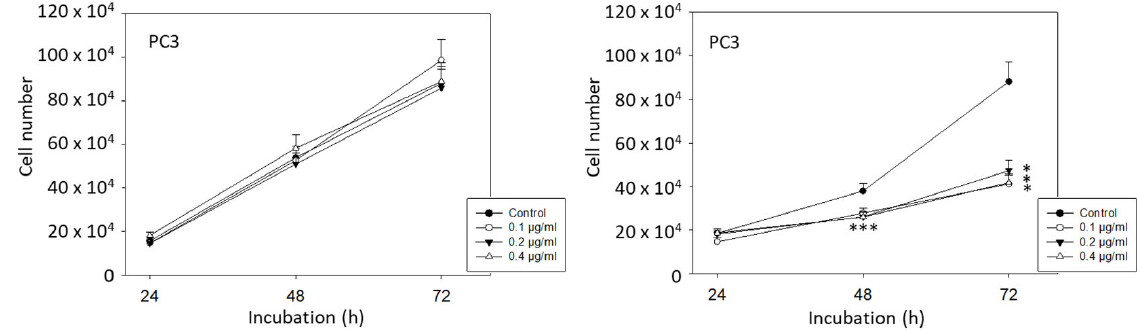
Figure 1. ( A ): Growth of DU145 and PC3 prostate cancer cells without irradiation. Cells were treated with 0.1, 0.2, or 0.4 µ g/mL curcumin and then assessed by MTT assay. Controls remained untreated. ( B ): Growth of DU145 and PC3 prostate cancer cells treated with curcumin and visible light (5 min at 1.65 J/cm 2 ). Controls were irradiated without curcumin. Each experiment was performed in triplicate and repeated 6 times. Data from one representative experiment is shown. Error bars indicate standard deviation; * indicates significant difference to controls. *** related to all 0.1, 0.2, and 0.4 µ g/ml.